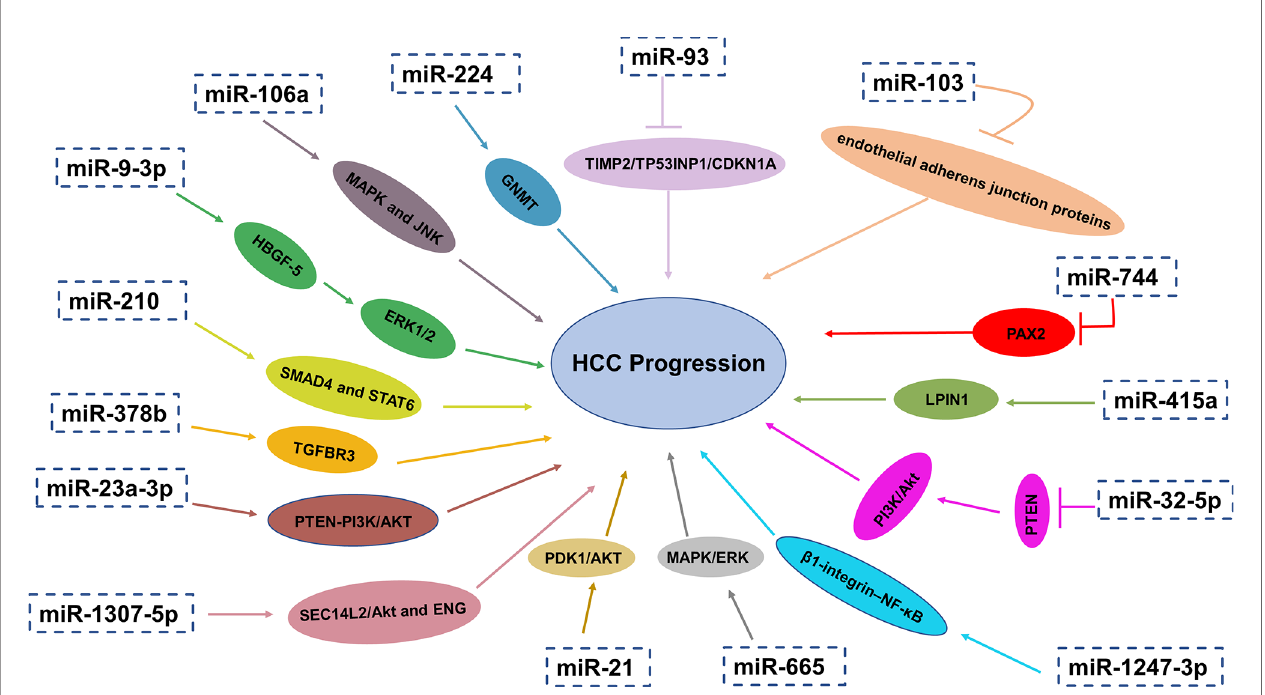
FIGURE 2 | Exosomal miRNAs play a crucial role in HCC progression through different pathways and